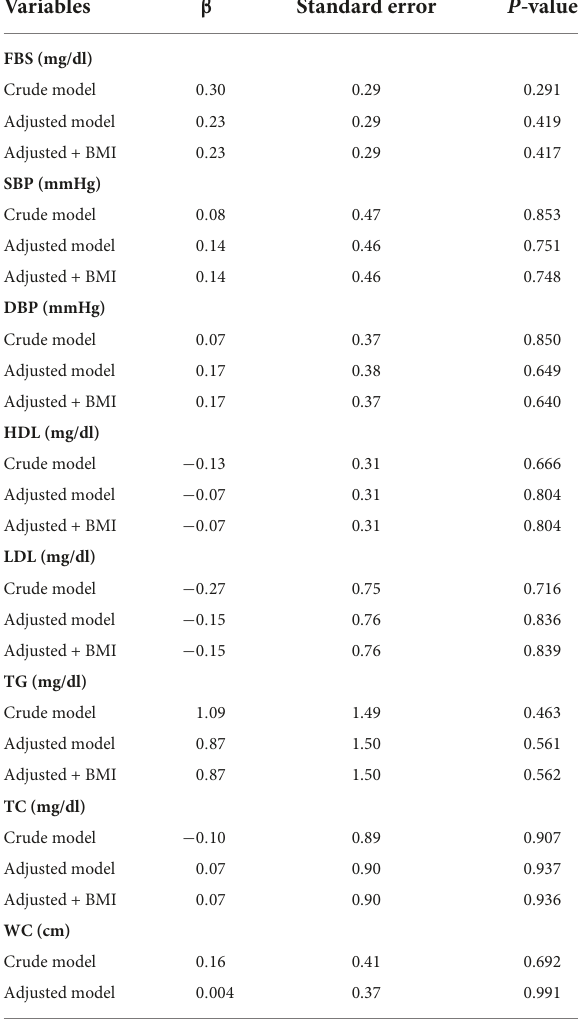
TABLE 2 Association between metabolic syndrome components and dyslipidemia with serum zinc level in children: linear regression